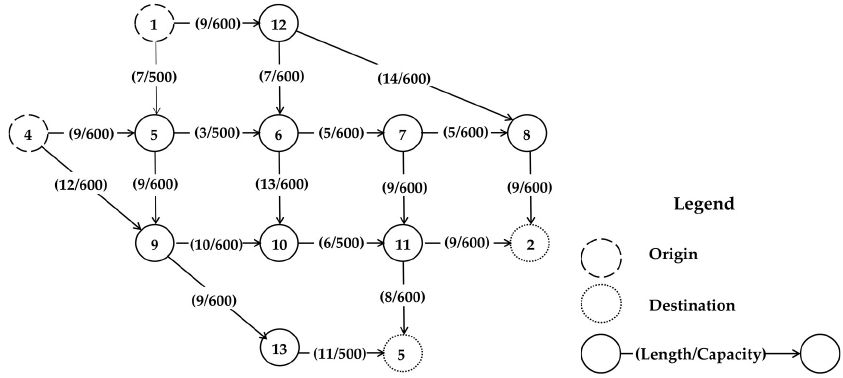
Figure 3. Nguyen–Dupuis network. Table 2. Path compositions and lengths in the Nguyen–Dupuis network.